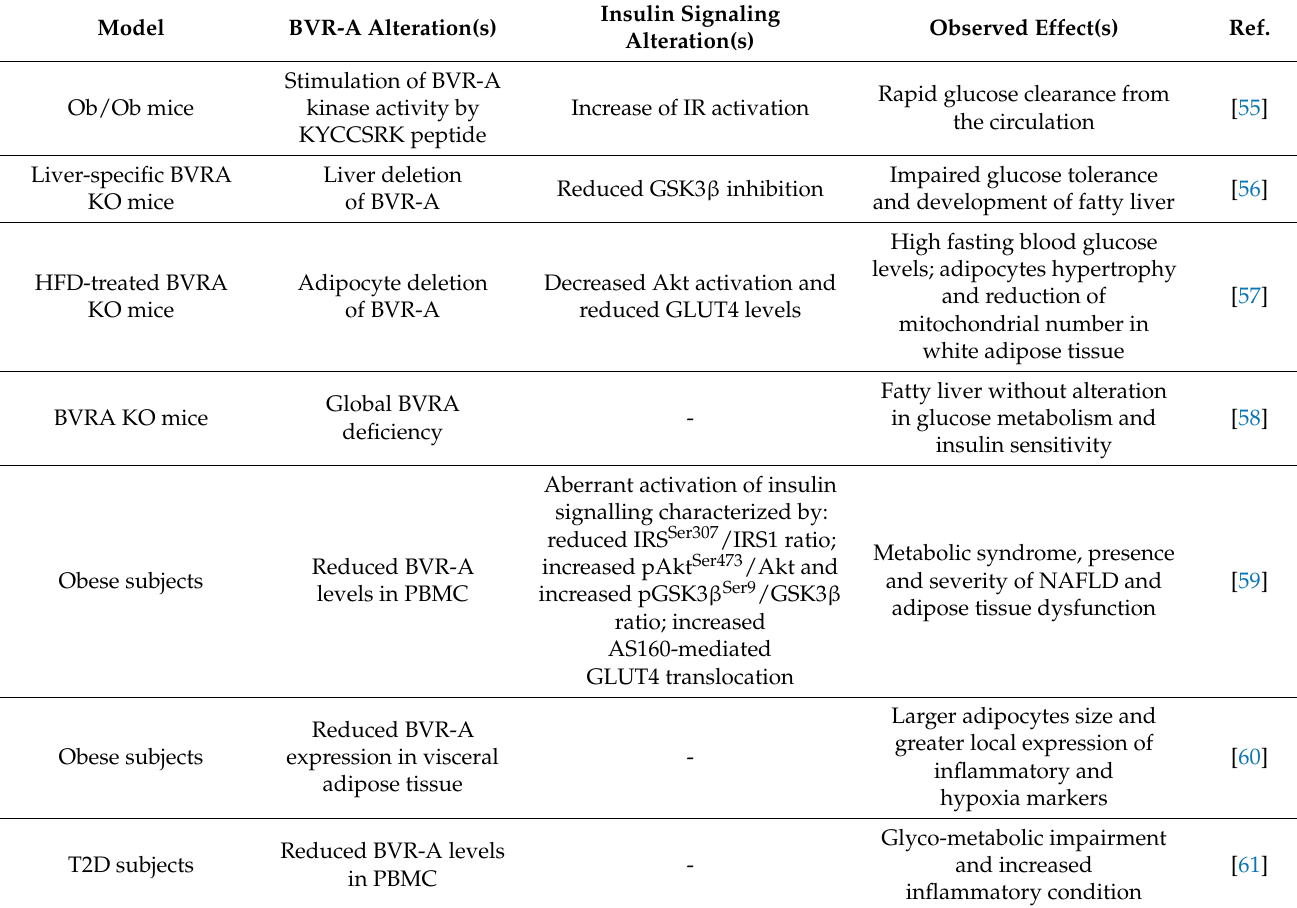
Table 1. Summary of the studies highlighting a link between BVR-A alterations and insulin signaling- related pathways in metabolic